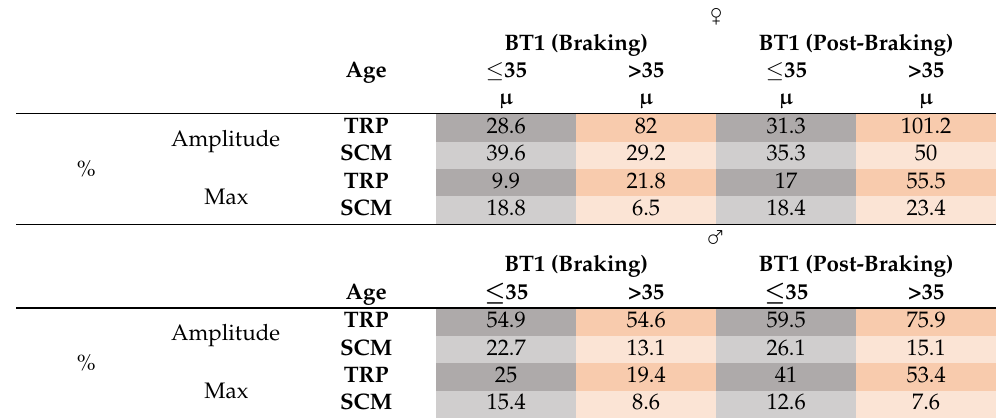
Table 6. sEMG parameters for BT1 (mean of the amplitude and maximum value reach) compute in the braking and post-braking phases (phase 2 and phase 3) sorted by age ( ≤ 35 and >35) and genre ( or ). P.P.O.M: Percentage of People Over the Mean; µ : mean value of the amplitude after ♀ ♂ normalisation